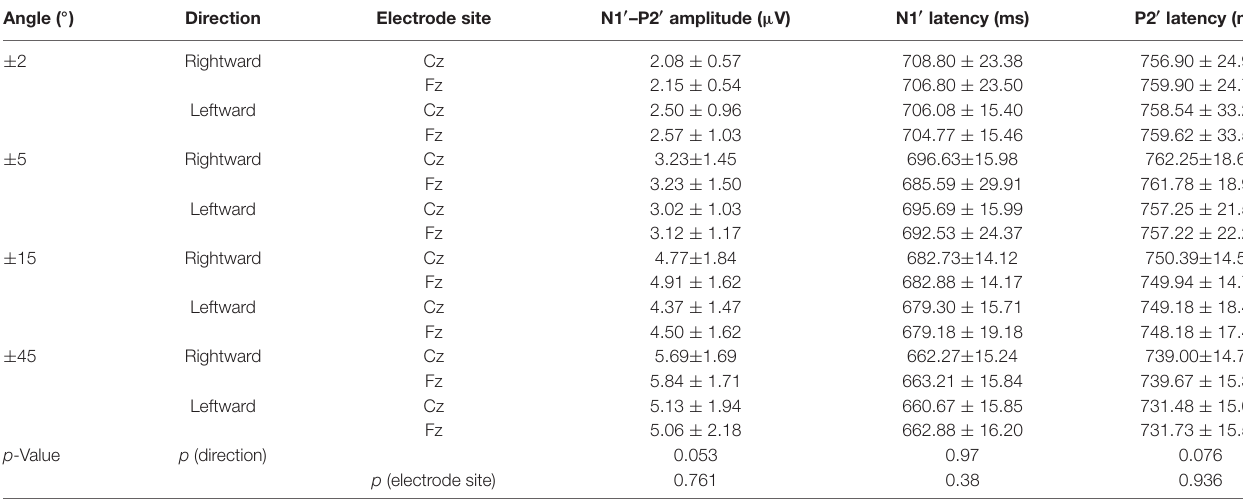
TABLE 3 | Mean and SD of N1 (cid:48) –P2 (cid:48) amplitude and N1 (cid:48) latency and P2 (cid:48) latency in different conditions. Angle ( ◦